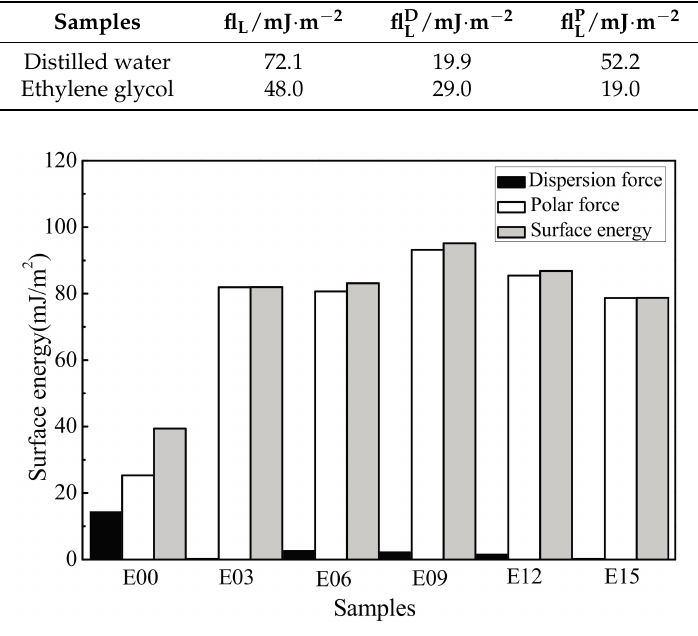
Figure 8. Surface energy of samples. E00: substrate; E03: 3 min; E06: 6 min; E09: 9 min; E12: 12 min; and E15: 15 min.